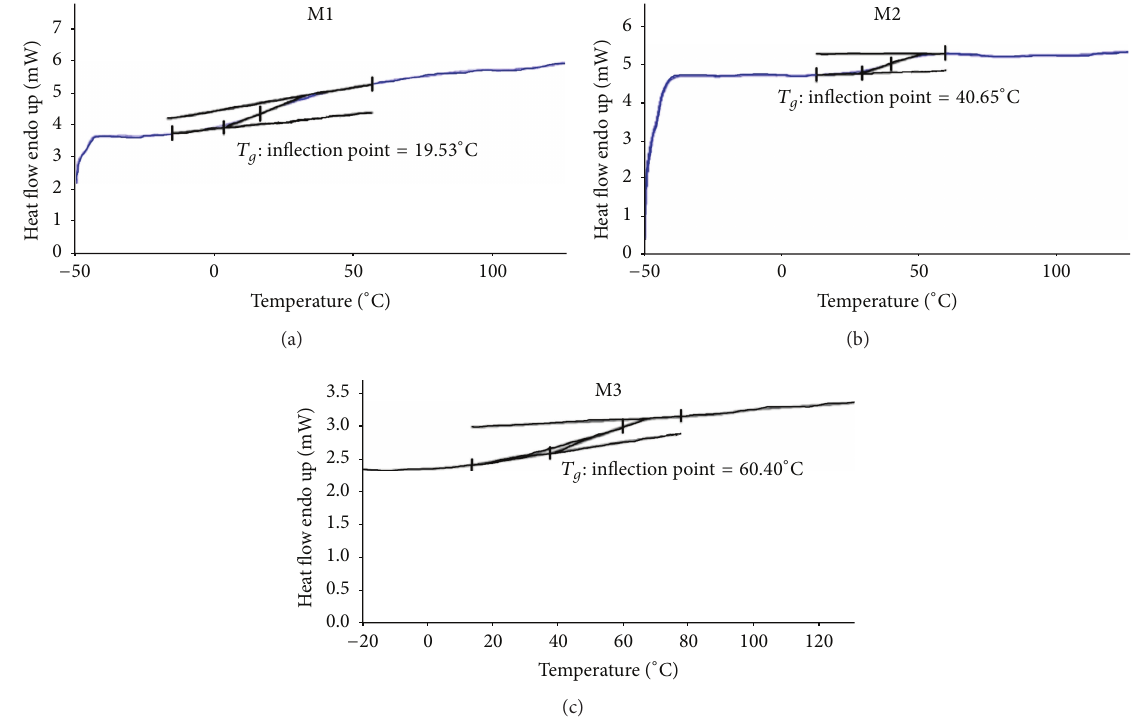
Figure 5: DSC thermograms of the prepared terpolymers M1, M2, and